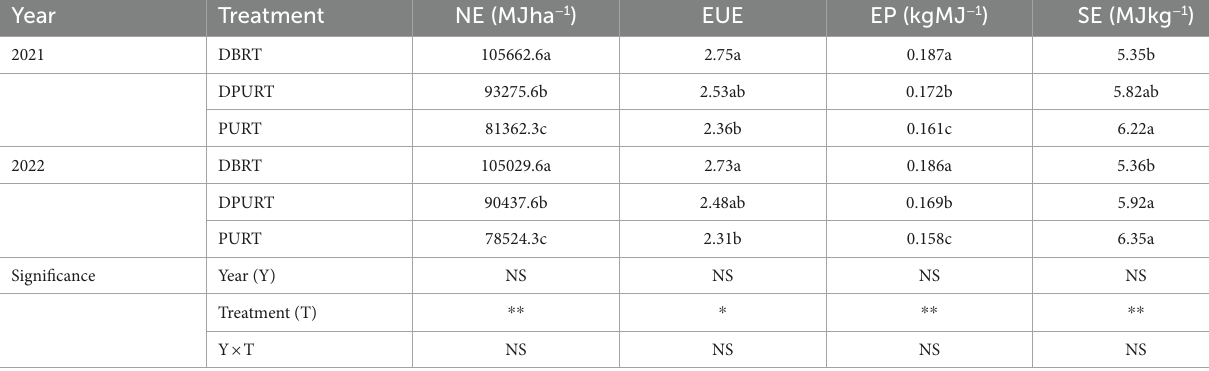
TABLE 8 Energy budget (MJ ha − 1 ) in the three tillage treatments in 2021 and